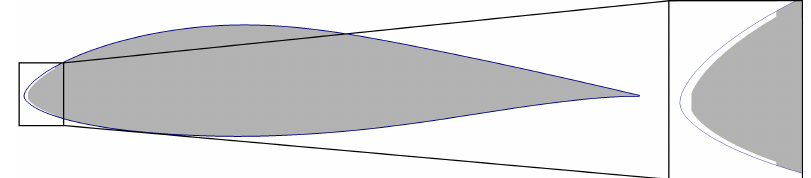
Figure 3. Sketch and close-up view of erosion modelled by a deformed leading edge as it is used in the two-dimensional CFD simulations (erosion model in grey and original DU 96-W-180 in blue).